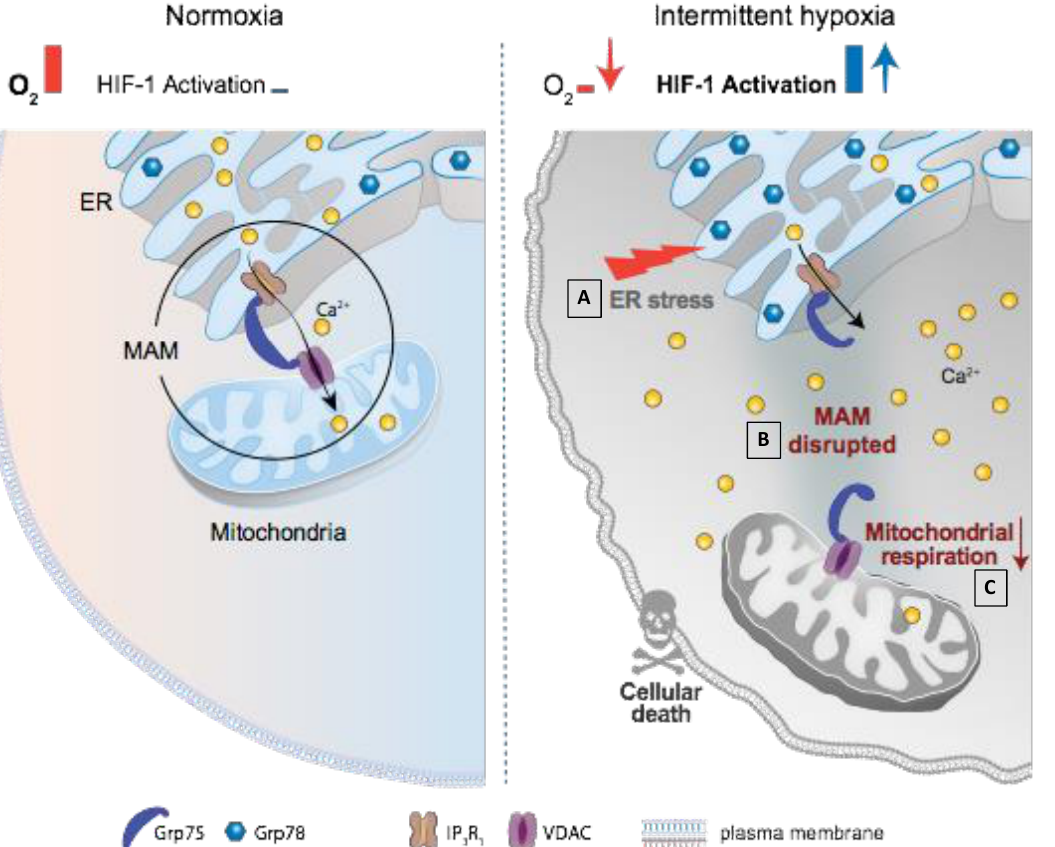
Figure 7. Graphical abstract. Normoxia is represented on the left panel. The communication between endoplasmic reticulum (ER) and mitochondria through the mitochondria-associated ER membrane (voltage anion dependent channel (VDAC), Inositol tri-Phosphate Receptor 1 (IP3R1), and glucose regulated protein-75 KDalton (Grp75)) maintains Ca 2+ homeostasis, ER homeostasis and cell life. On the right panel, intermittent hypoxia (IH) induces cell death. IH leads to HIF-1 activation responsible for ER stress ( A ), MAM disruption ( B ), Ca 2+ homeostasis alteration, mitochondrial dysfunction ( C ), and cardiomyocyte death.